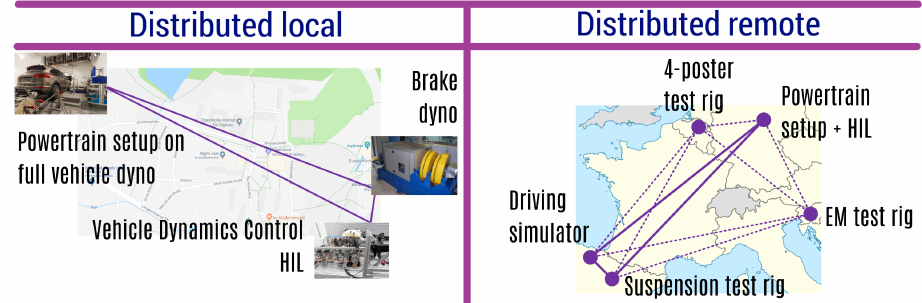
Figure 2. Distributed local ( left ) and distributed remote ( right ) XILforEV architecture. X-in-the-loop (XIL), electric vehicles